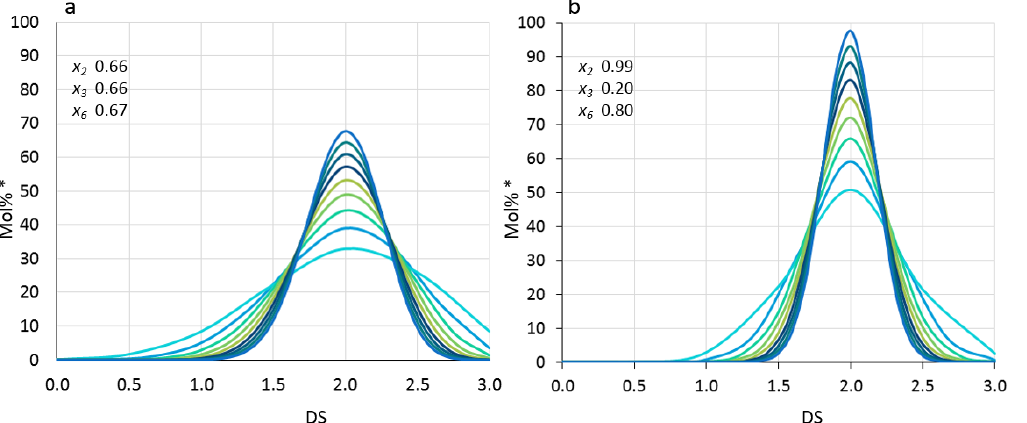
Figure 2. Methyl distribution profiles for domains with increasing number of AGU (DP2-10, starting with the broadest profile for DP2, ending with the narrowest for DP10) in two MCs, both with DS 1.99. ( a ): equal distribution on positions O-2, O-3, O-6; ( b ): preferred methylation at O-2 followed by O-6 and O-3. Partial DS values x i are given in the legend. * The Mol% scale does refer to 7 data points for DP2. All other profiles with increasing number of data points are normalized to DP2 for comparability.